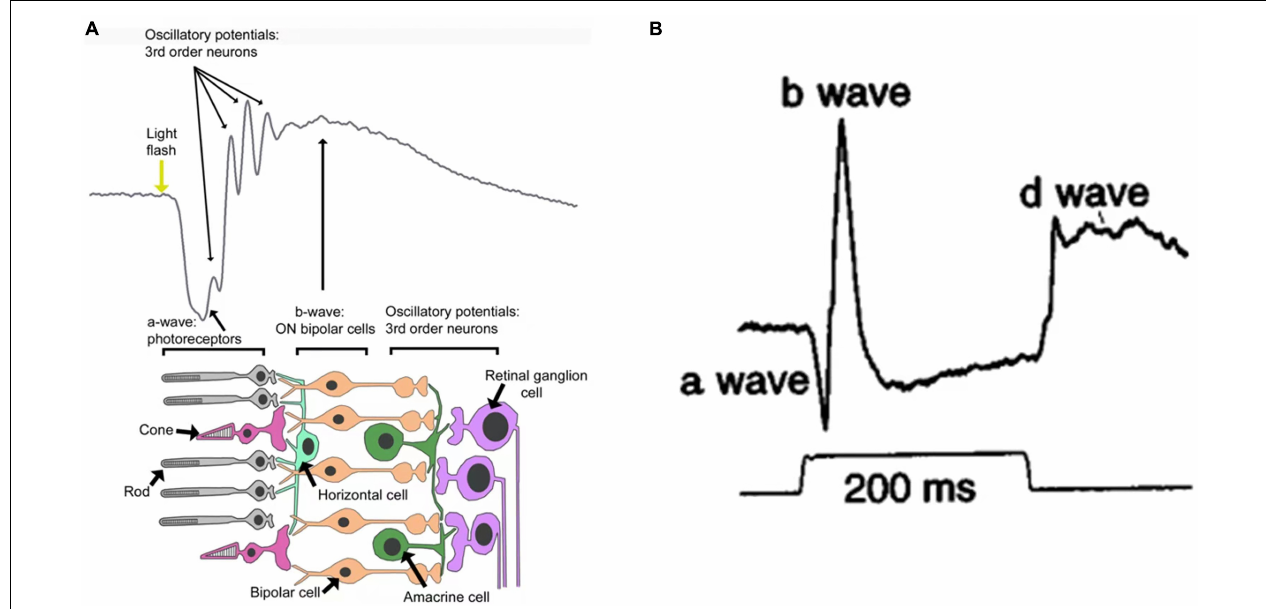
FIGURE 1 | (A) Schematic representation of a flash electroretinogram (ERG) and the retinal events contributing to it (Cameron et al., 2008). (B) Primate photopic ERG responses to 200 ms stimuli (Bush and Sieving,